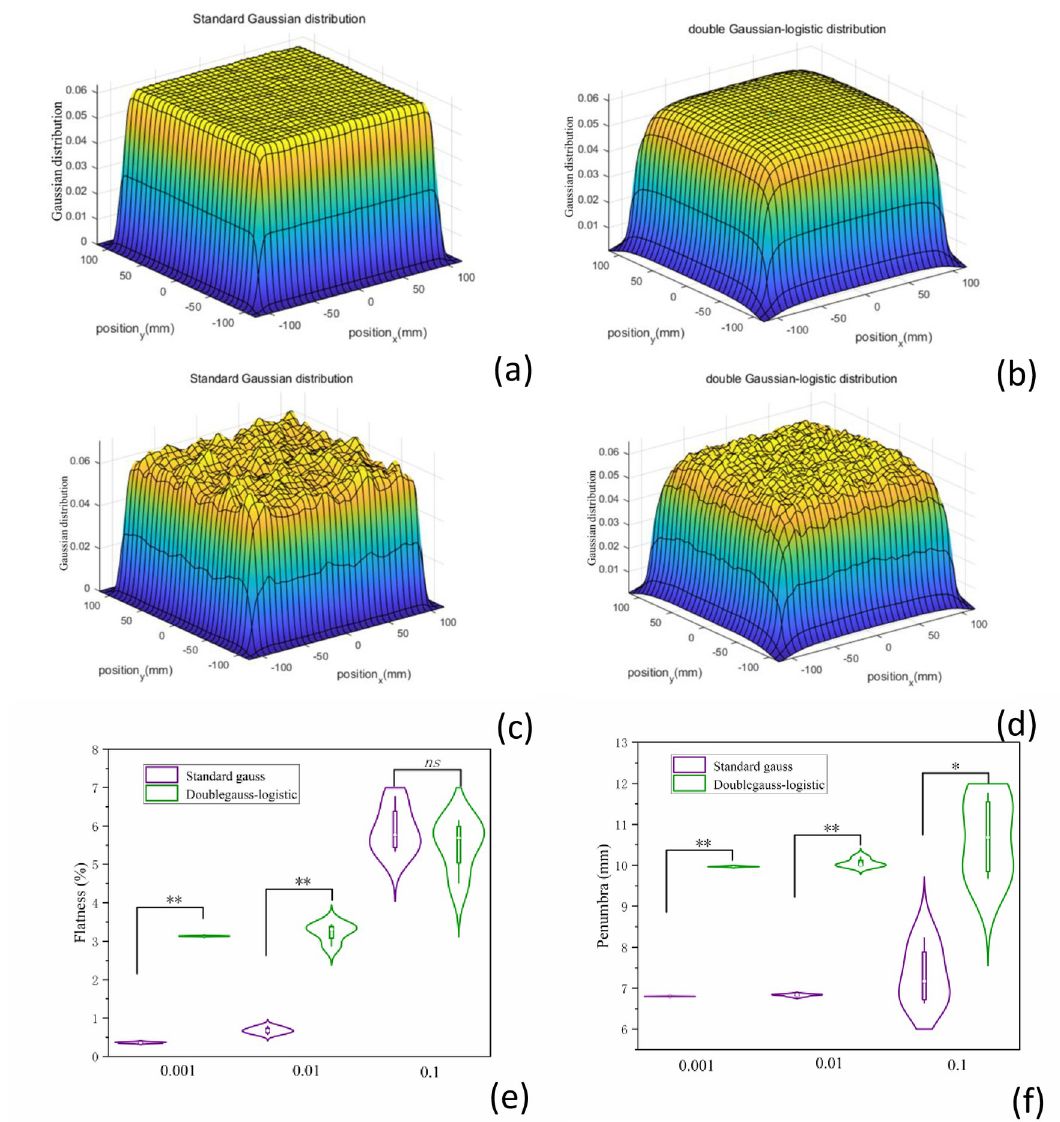
Fig 7. The influence of delivered dose accuracy on flatness and penumbra. (a-d) 3D Gaussian distribution with delivered dose error was plotted by MATLAB. (e) The influence of different random error (0.001, 0.01 and 0.1) on dose flatness, and (f) penumbra for PB scanning (PBS)